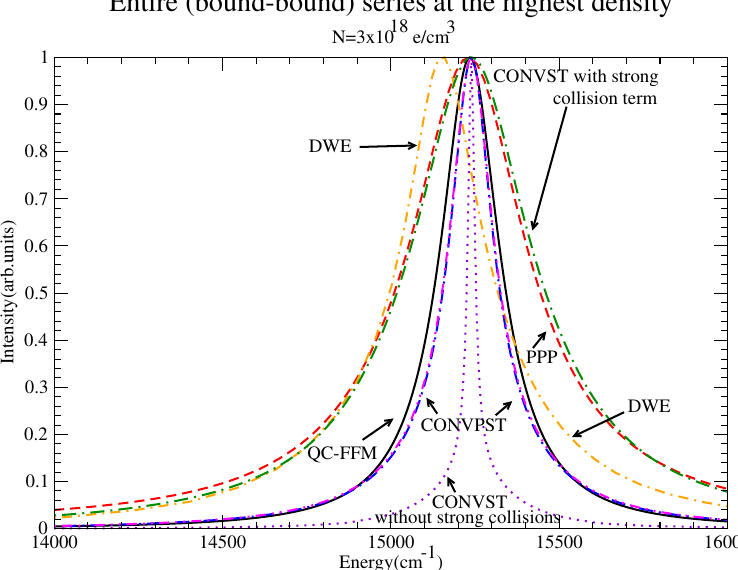
Figure 20. H α at the highest density showing a very good agreement between QC-FFM and CONVPST. Shown are QC-FFM (solid), PPP (dashed), DWE (dash-dotted), CONVST without strong collisions (dotted), CONVST with strong collisions (dot-double dashed), CONVPST without strong collisions (long dash-dotted) and CONVPST with strong collisions (dash-double dotted).